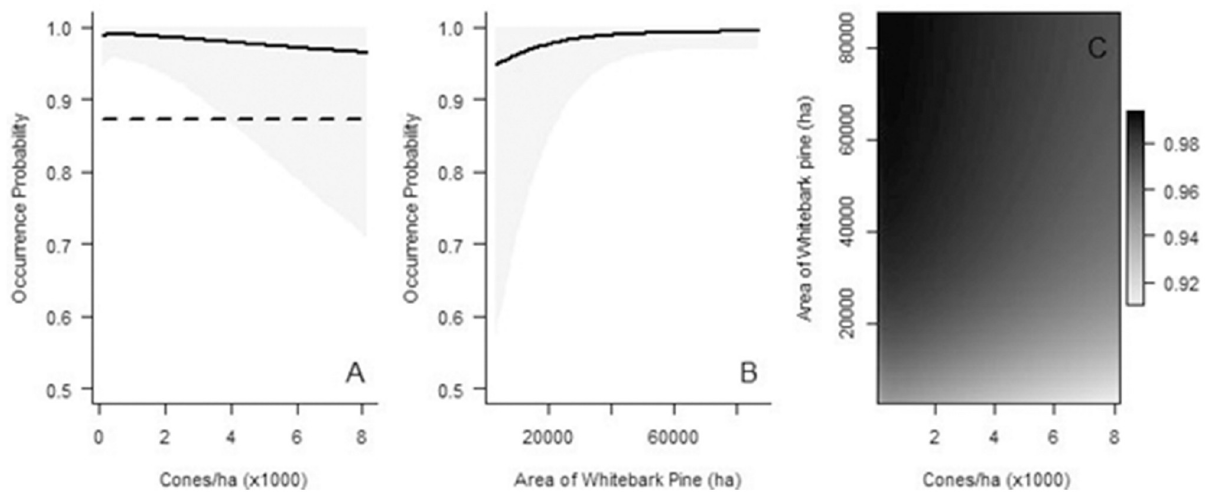
Fig 5. Predicted probability of Clark’s nutcracker occurrence during the fall harvest as a function of the (A) whitebark pine cones/ha, (B) area of whitebark pine on the landscape, and (C) both metrics. The graphs depict predictions based on data from infinite radius surveys. Values represent area of whitebark pine habitat within 32.6 km. On each graph, all variables in the models that are not shown on the graphs, are held at the mean. Gray shaded areas denote 95% Bayesian Credible Intervals. In A, the reference horizontal line shows the intercept when no cones are